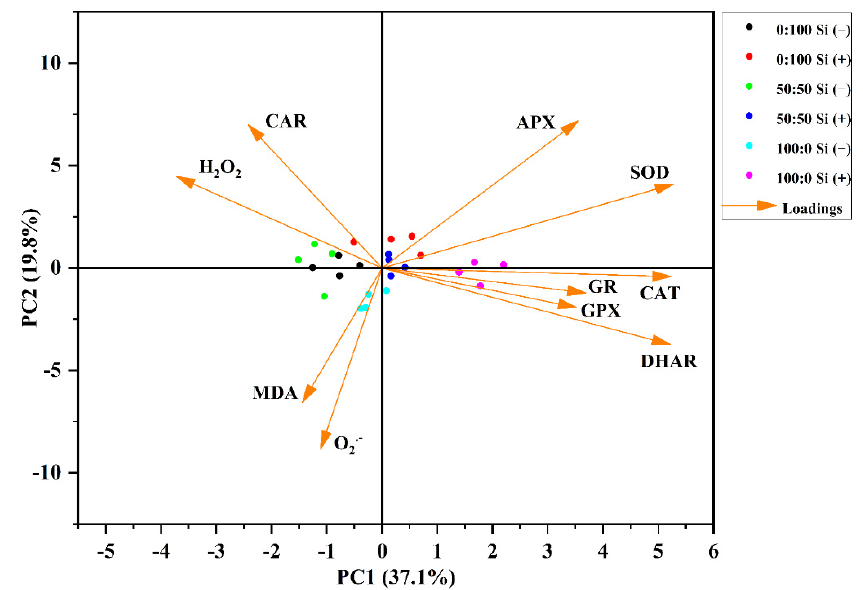
Figure 7. Multivariate data analysis using principal component analysis (PCA) of indices involved in antioxidant defense and oxidative damage. SOD: superoxide dismutase, APX: ascorbate peroxidase, CAT: catalase, GPX: guaiacol peroxidase, GR: glutathione reductase, DHAR: dehydroascorbate reductase, O 2 ·− : superoxide anion, H 2 O 2 : hydrogen peroxide, MDA: malondialdehyde, CAR: carotenoids.